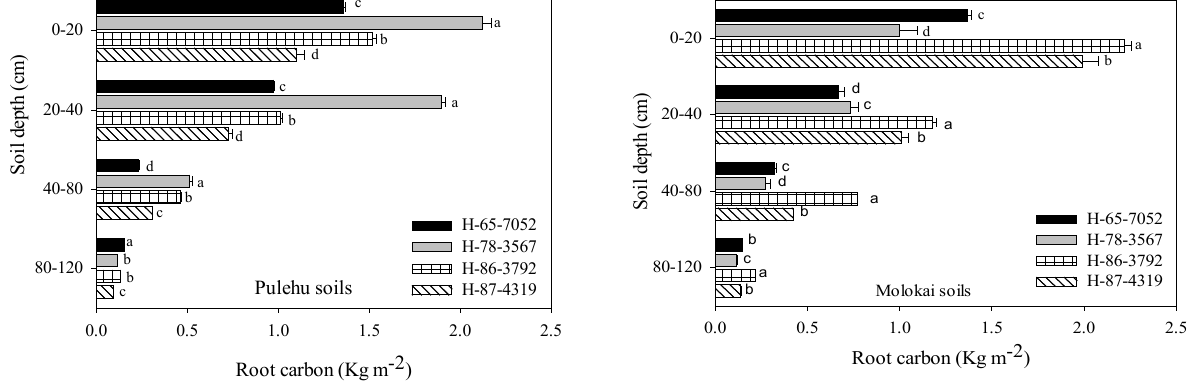
Figure 10. Root carbon (kg·m −2 ) from sugarcane cultivars collected less than two weeks prior harvest date. Means from sugarcane cultivars bars followed by the same letter or no letters are not significantly different Tukey’s test at Pr <